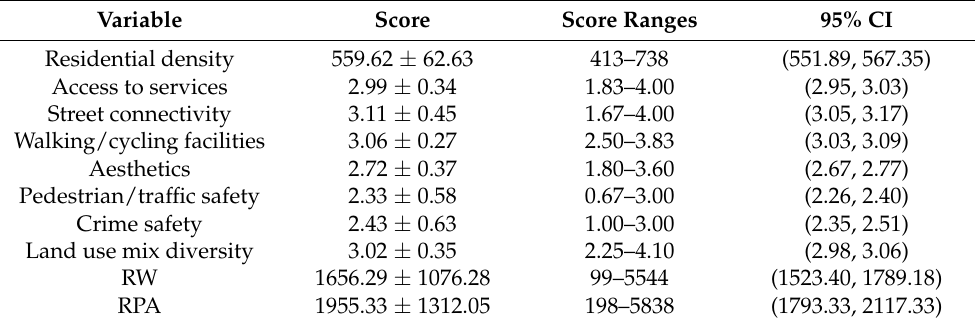
Table 2. The perceived built environment scores, recreational walking (RW), and recreational physical activity (RPA) level of older people in the city of Yiwu ( n = 252). Variable Score Score Ranges